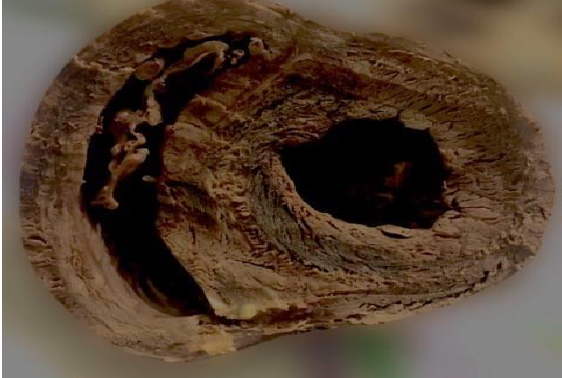
Figure 10. The "opening-technique” of ventricular myocardium.